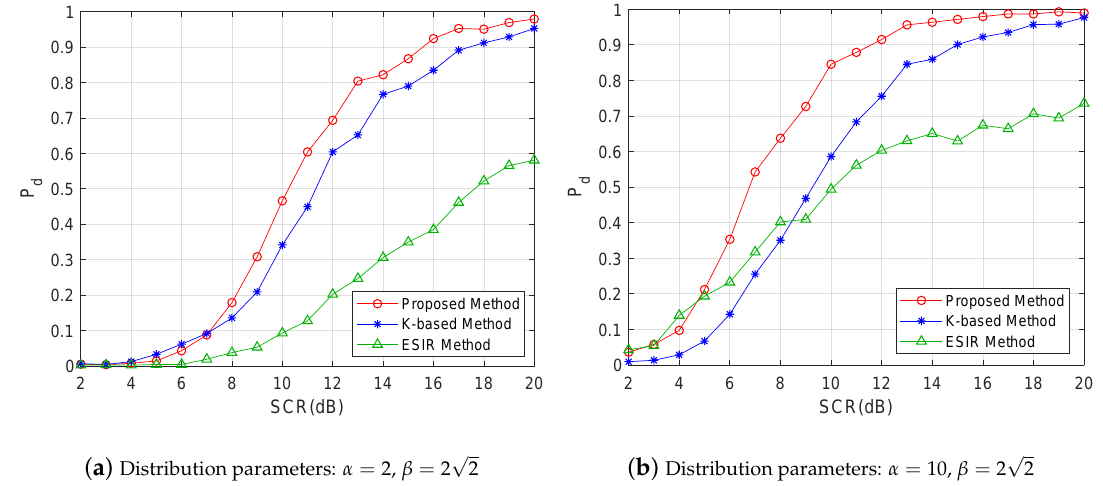
Figure 12. Detection probabilities of the three methods in case of P fa = 10 − 2